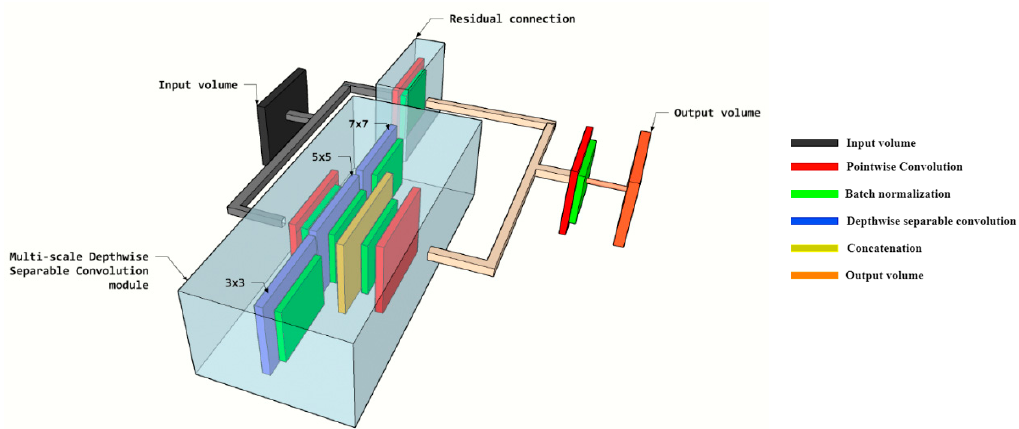
Figure 3. 3D representation of the main multi-scale building block of look-behind fully convolutional neural network (LB-FCN) light architecture adopted in this study.